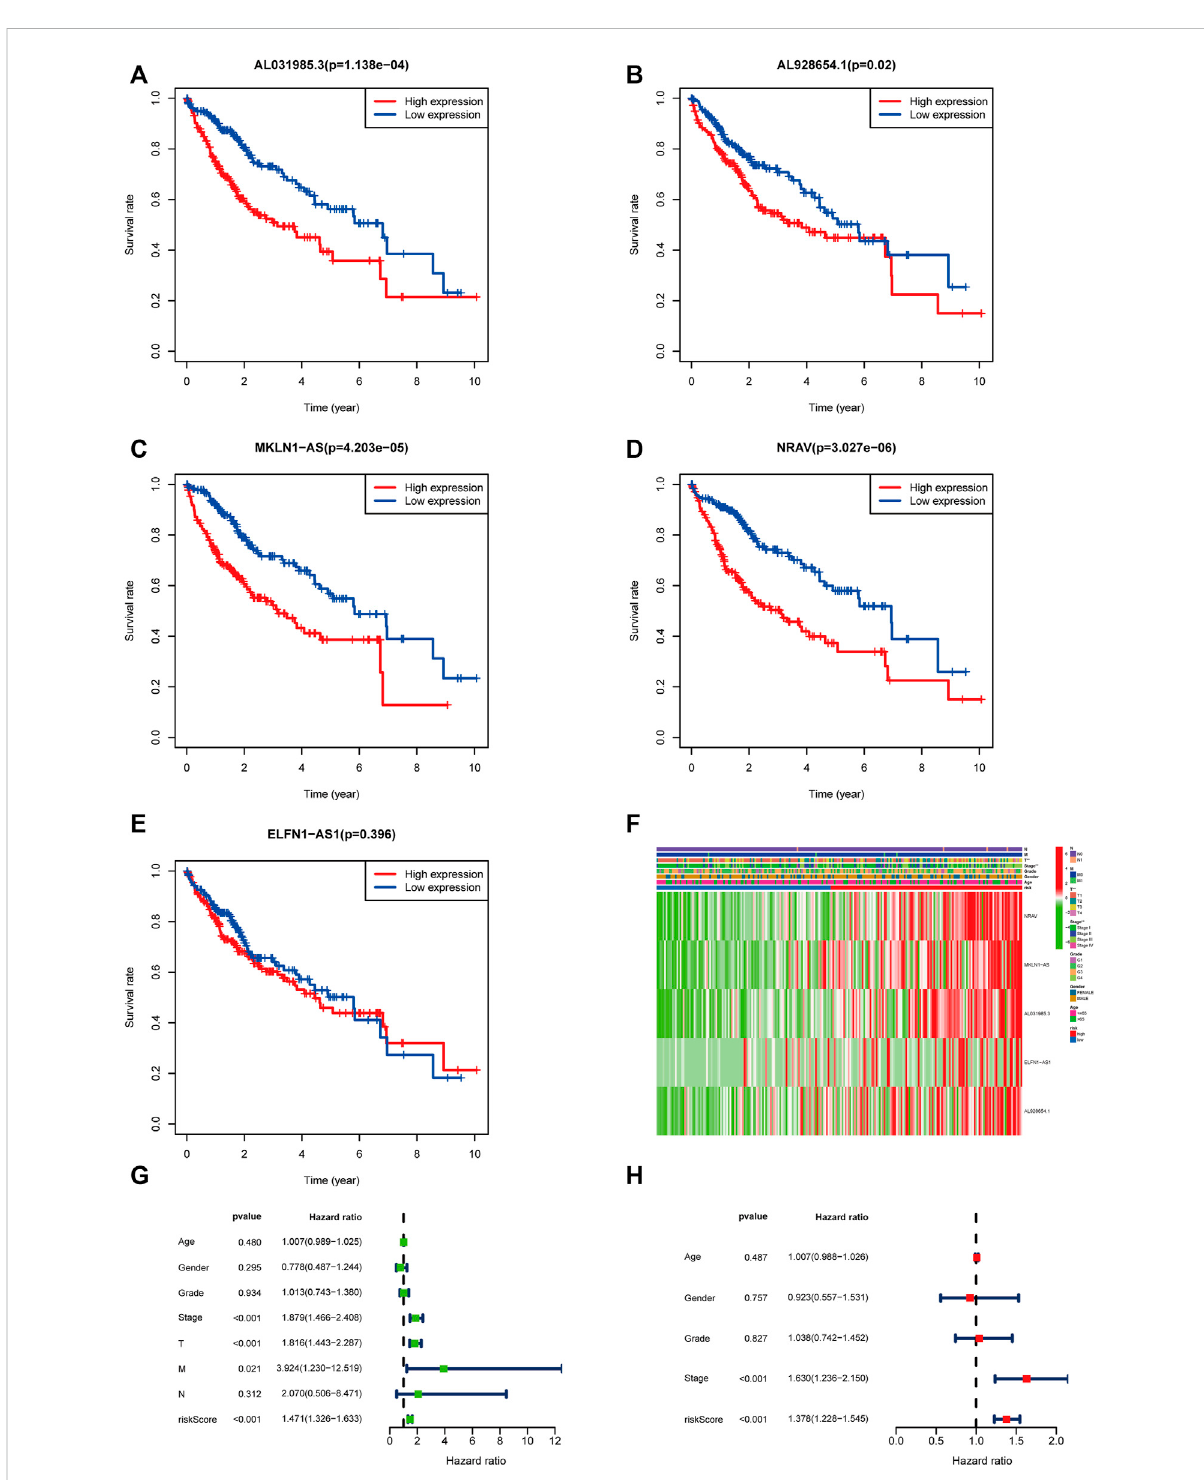
FIGURE 5 Validation of the m5C-related lncRNAs risk score as an independent prognostic factor in HCC patients. (A – E) KM survival curves indicated the relationship of the fi ve lncRNAs with prognosis in HCC patients. (F) Heatmap showing the correlation between expression levels of the fi ve m5C- lncRNAs and clinicopathological features. (G,H) Univariateand multivariate Cox regression analysis of riskscore